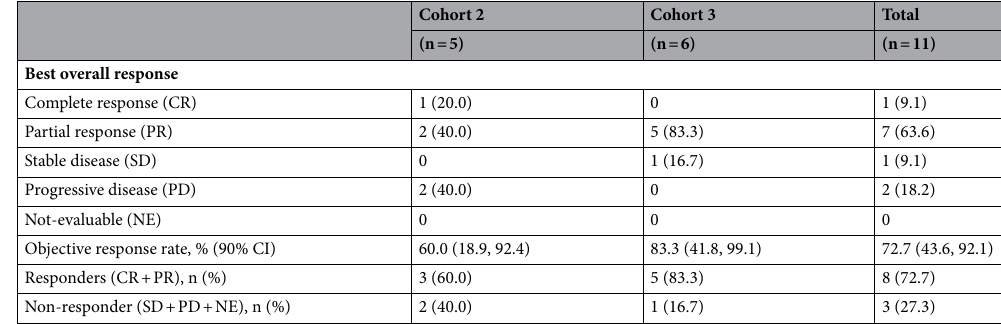
Table 4. ORR in patients with measurable lesions. The safety analysis set includes subjects who received at least one dose of ADX. Objective response rate is defined as (number of responders)/(number of